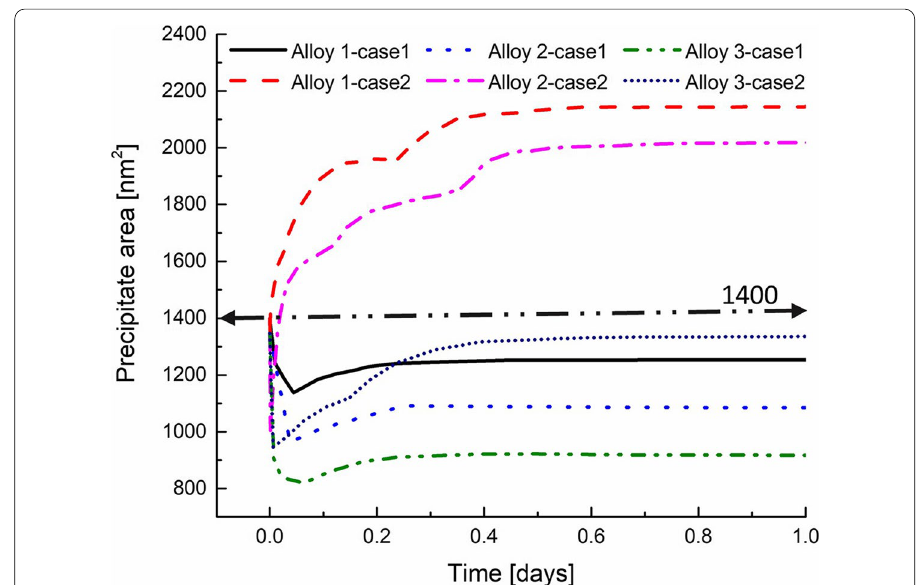
Fig. 8 Comparison of the evolution of BCC precipitates area with the time for different alloy systems and different initial conditions of the matrix